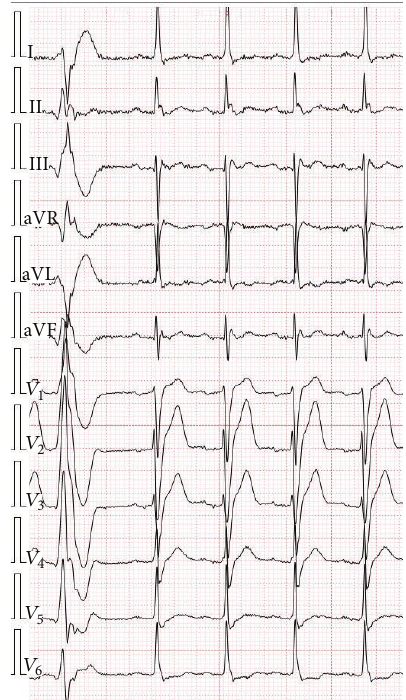
Figure1:ECGatrest.Sinusrhythm94bpm,singleprematureventricularcomplexes.Signsofleftventricularhypertrophyandatrioventricular (PQ 220 ms) and interventricular conduction abnormalities (QRS 120 ms). Recorded at 25 mm/sec, 10mm/mV.